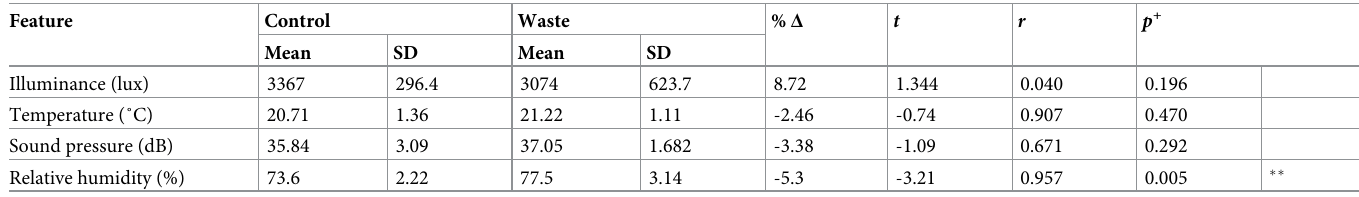
Table 1. Results of the t-test comparison between the control and experimental settings (physical environment); also reported in Bielinis et al. 2020 (not published). Feature